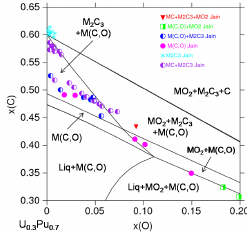
different sets of stable phases.